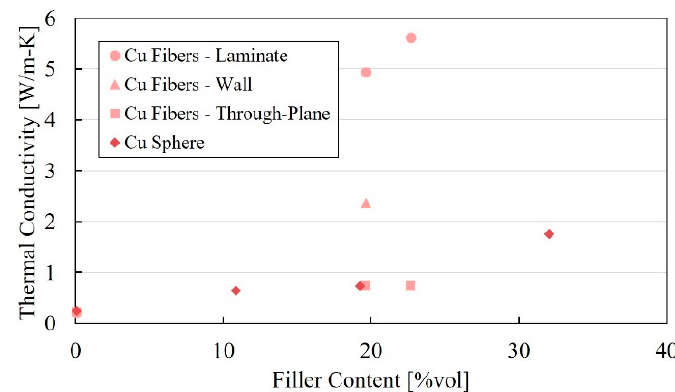
Figure 10. Thermal conductivity at 70 °C in the flow direction is many times higher than the through-plane direction. Sphere-filled PA6 performs about the same as the fibers through-plane.